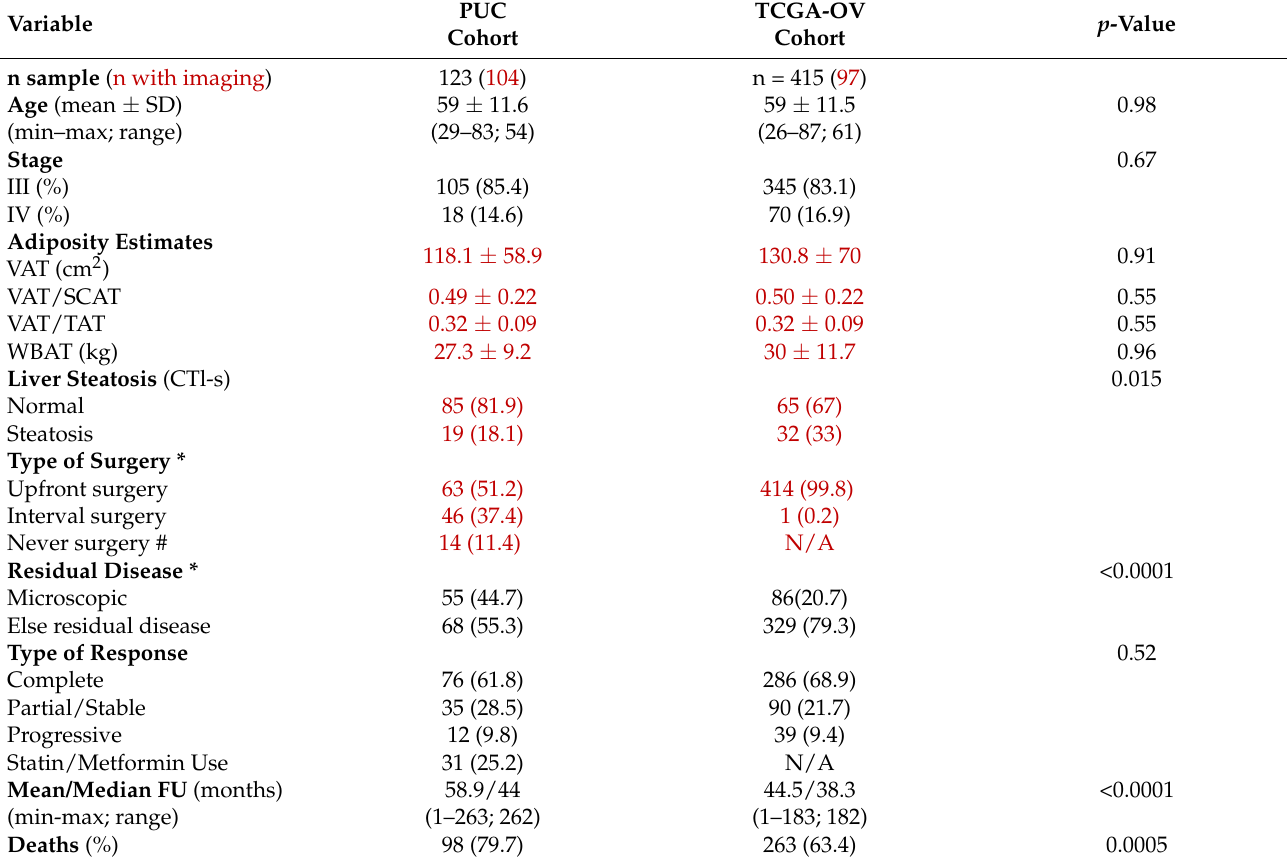
Table 1. Comparative clinical characteristics of the PUC and TCGA-OV